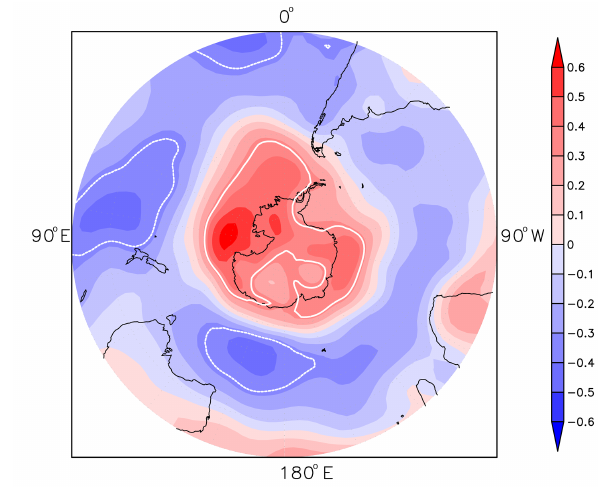
Figure 14. The CC between WHD NCP DY and September–October Z850 DY from 1980 to 2013. The white curves indicate that the CC exceeded the 95% confidence